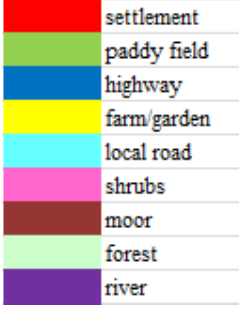
Figure 2. Class colour